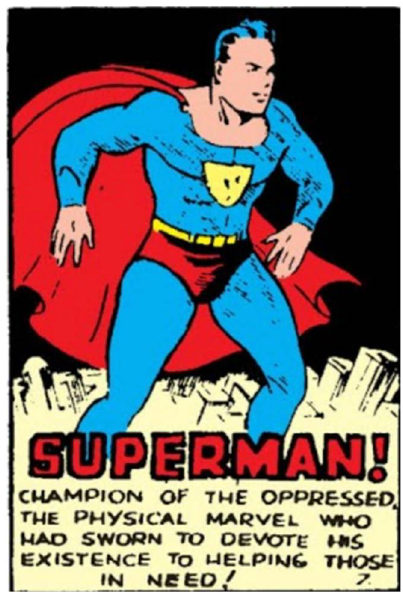
Figure 1. Joe Shuster, “Superman! Champion of the Oppressed” (panel No. 7), 1938. Siegel and Shuster (June 1938), “Superman”, Action Comics #1 (Siegel and Shuster 1938a, p. 8). © DC Comics.